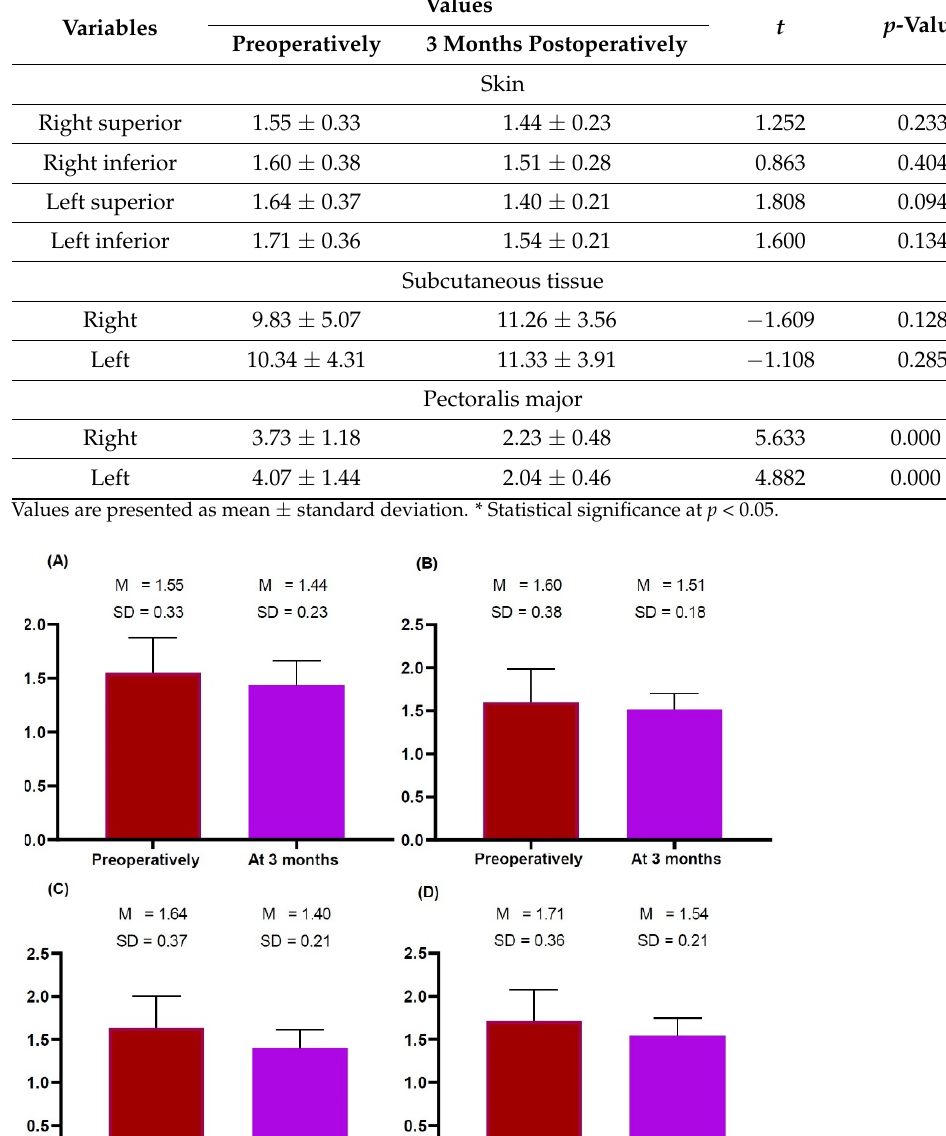
Table 3. The thickness of the dermis, subcutaneous tissue and pectoralis major measured on breast ultrasound.